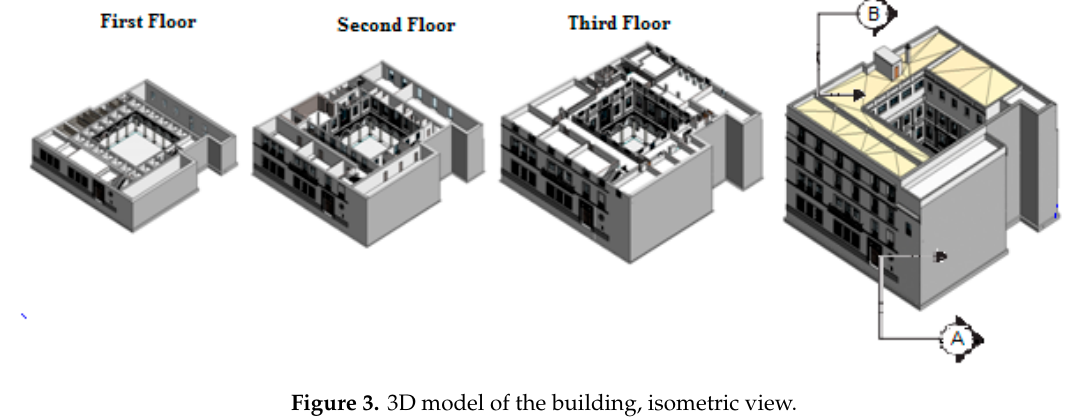
Figure 3. 3D model of the building, isometric view.